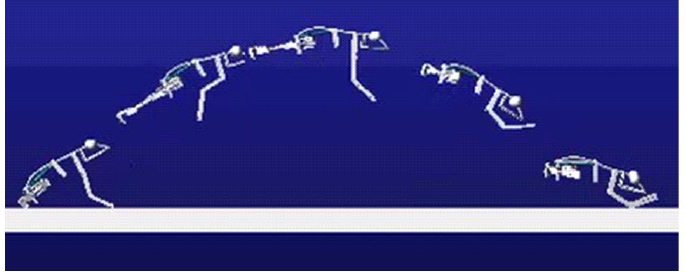
Figure 5. Simulation process of jumping motion of simplified frog mechanism model.